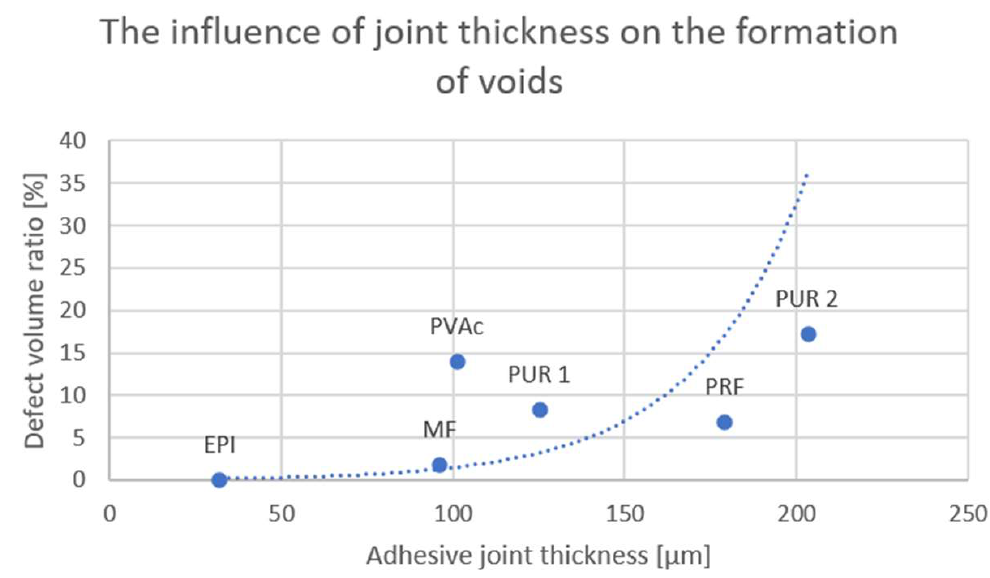
Figure 4. The influence of the joint thickness on the formation of voids.